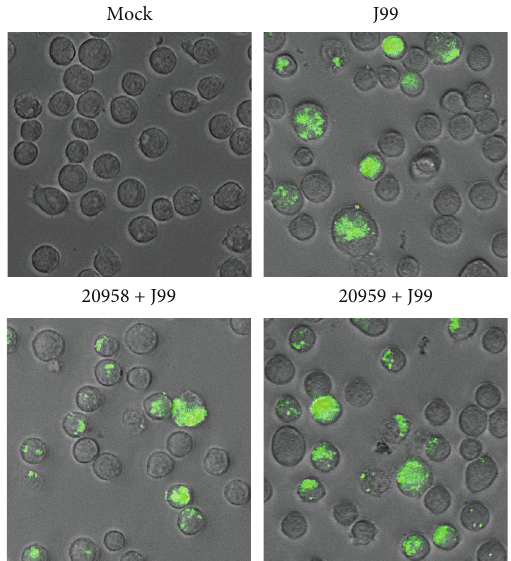
Figure 7: Unperturbed bacteria internalization in THP-1 macrophage with or without TLR7 and TLR8 inhibition. THP-1 cells were uninfected (mock), infected with H. pylori J99 strain conjugated with FITC at MOI 10 for 16 hours, or infected after treatment with TLR7 inhibitor (ODN20958+ J99) or TLR7/8 inhibitor (ODN20959 +J99) for 4 hours. Cells were stripped o ff extracellular bacteria and viewed under fl uorescent microscope. Data are representative of at least 10 images (Figure 5). Pretreatment of THP-1 cells with TLR7 antago- nist ODN20958 prior to H. pylori infection marginally